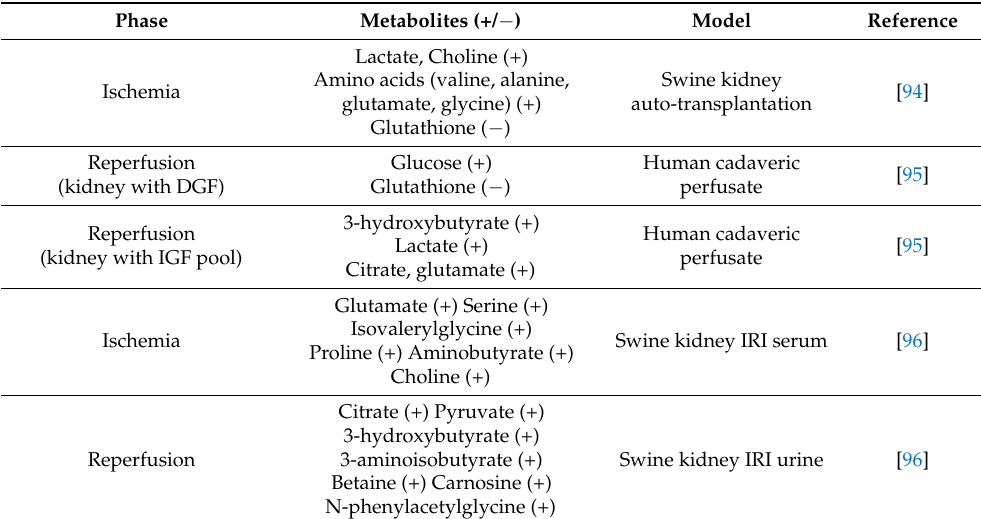
Table 1. Main metabolic alteration described in different kidney transplant models. DGF: delayed graft function; IGF: immediate graft function; (+) increased levels; ( − ) reduced levels. Phase Metabolites (+/ − ) Model Reference Lactate, Choline (+) Amino acids (valine, Ischemia